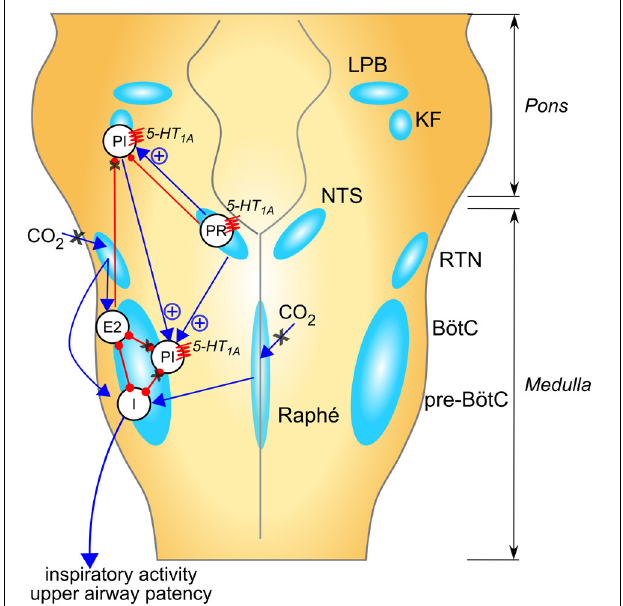
FIGURE 1 | Suggested mechanisms for respiratory rhythm disease in Rett syndrome and network targets of 5-HT 1A agonists. Populations of respiratory neurons are shown in white circles (see below). Blue arrows indicate excitatory drive; red connectors with circle-ends indicate inhibitory drive. A healthy respiratory rhythm and pattern are critically dependent on the balance between excitatory and inhibitory synaptic drives to the “core” of mutually inhibitory respiratory neurons located in the BötC and pre-BötC (Smith et al., 2013). The disturbed rhythm in Rett syndrome seems to arise from an imbalance of drives to this core circuitry (indicated by black “X” when reduced, or blue “ + ” when enhanced); many mechanisms contribute to this: (i) weakened excitatory synaptic drives to and within the inspiratory “kernel” (Viemari et al., 2005), (ii) reduced CO 2 sensitivity (Zhang et al., 2011; Toward et al., 2013; Bissonnette et al., 2014); (iii) excess descending post-inspiratory drive from the pontine parabrachial complex (Stettner et al., 2007; Voituron et al., 2010; Dhingra et al., 2013); which could be a consequence of loss of inhibitory drives to this area, including KF (Stettner et al., 2007; Abdala et al., 2010). In combination, these mechanisms would lead to disinhibition of PI populations, disruption of timing for termination of inspiration and expiratory length irregularity. Studies in humans and mice suggest that breath-holds and Valsalva maneuvers may be linked to active closure of the glottis implicating a failure in the ponto-medullary gating of central post-inspiratory activity, for a review; see Ramirez et al.